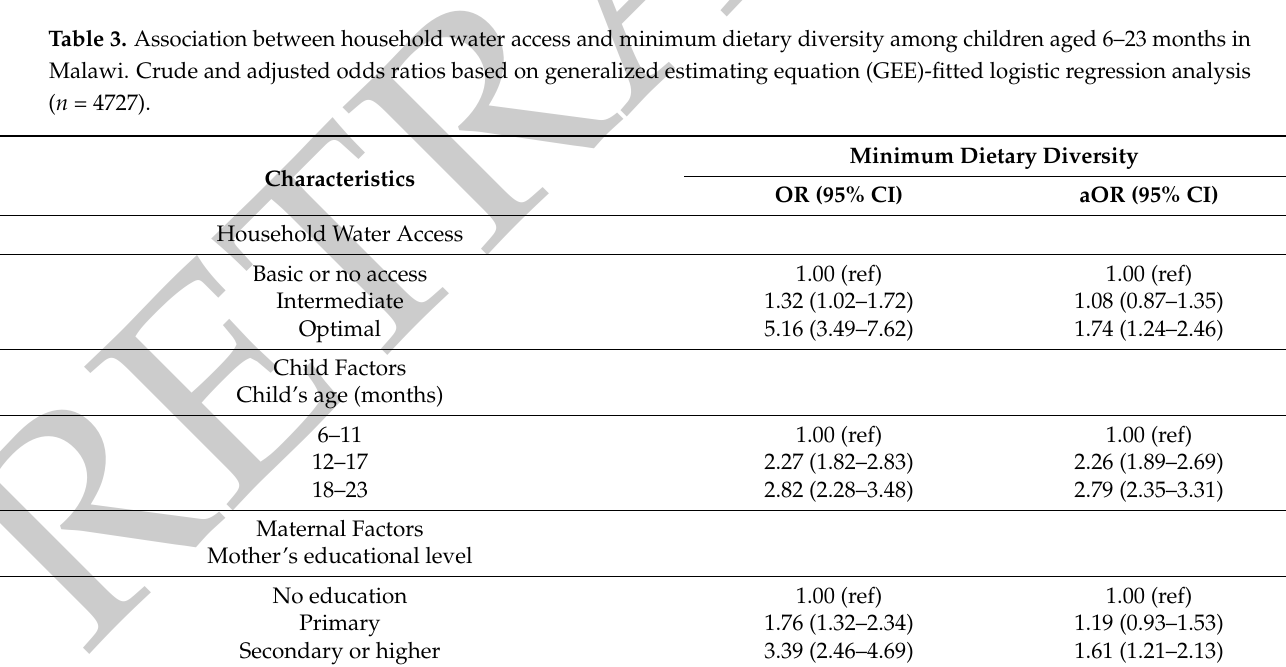
Table 3. Association between household water access and minimum dietary diversity among children aged 6–23 months in Malawi. Crude and adjusted odds ratios based on generalized estimating equation (GEE)-fitted logistic regression anal- ysis ( n = 4727).